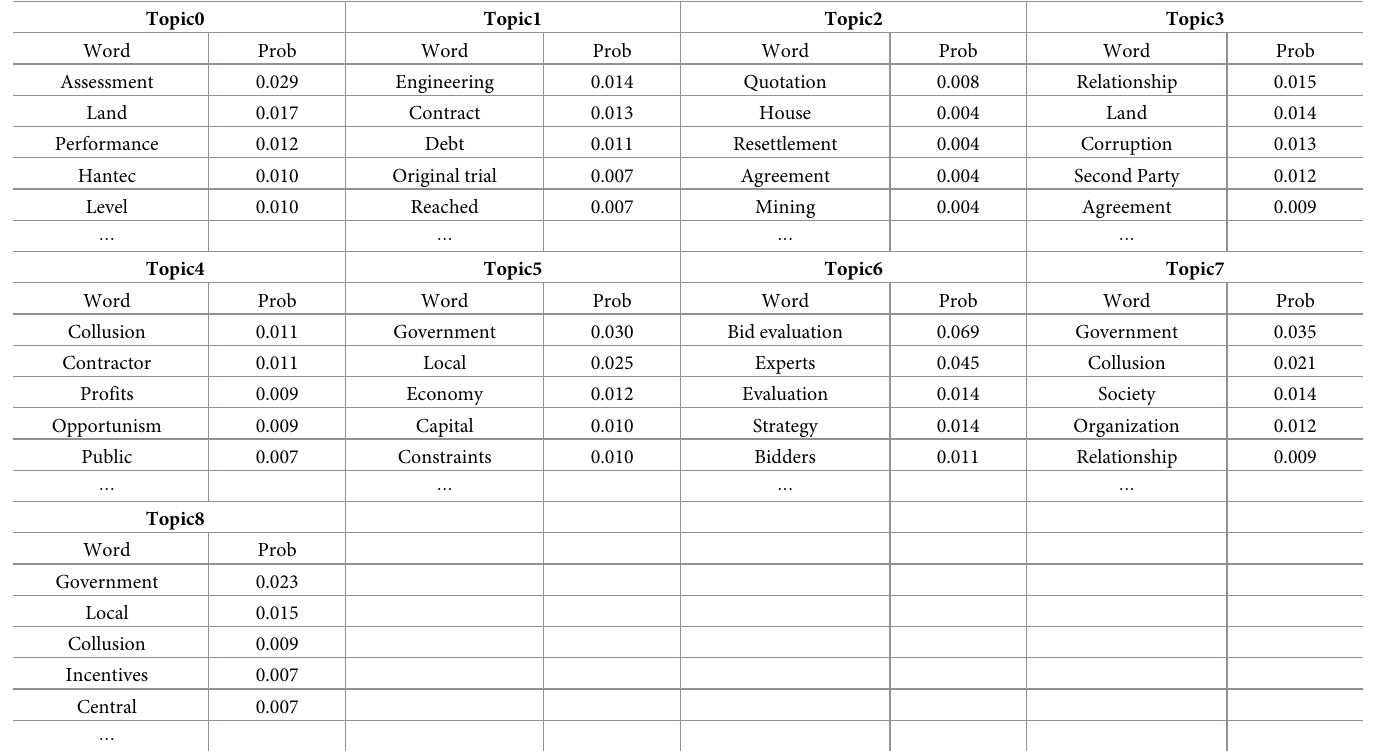
Table 1. Analysis results of high-frequency subject words in the LDA model.